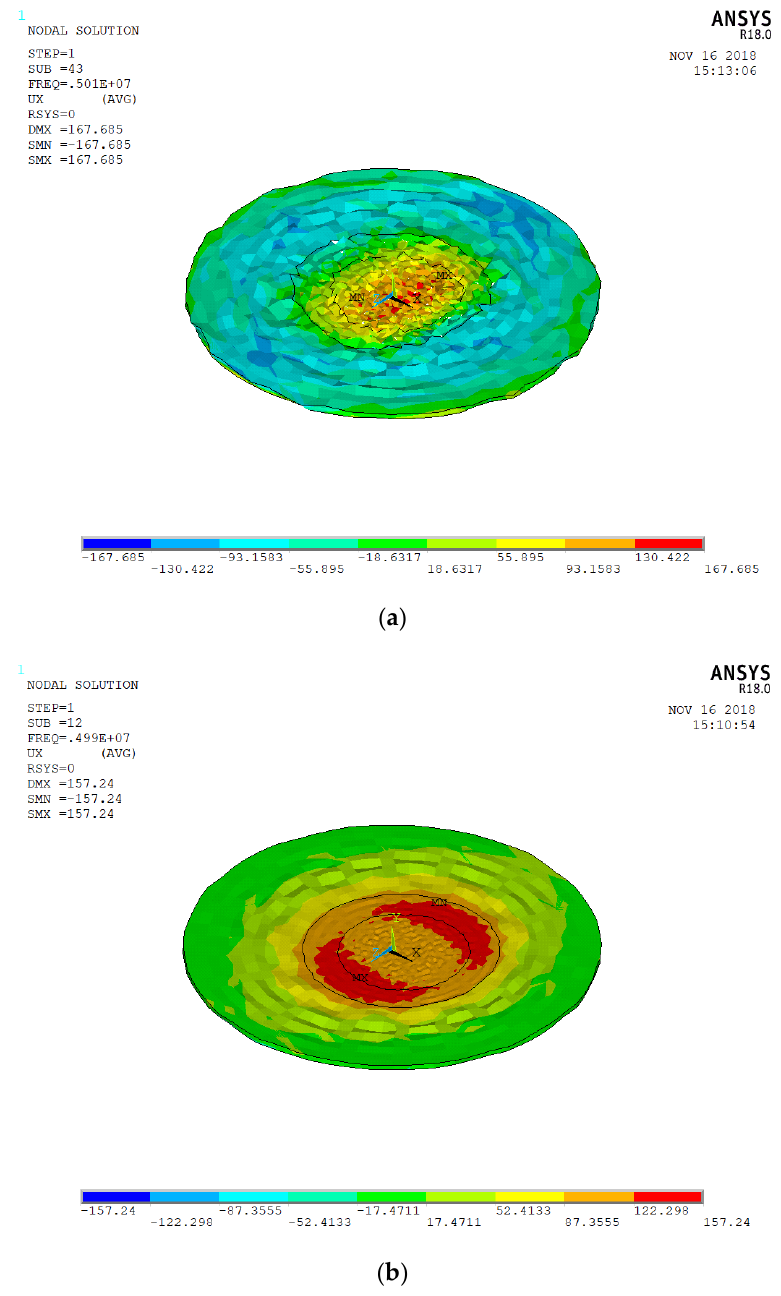
Figure 2. ( a ) The energy-trapping diagram of the 43rd modal subsets; ( b ) the energy-trapping diagram of the 12th modal subset.